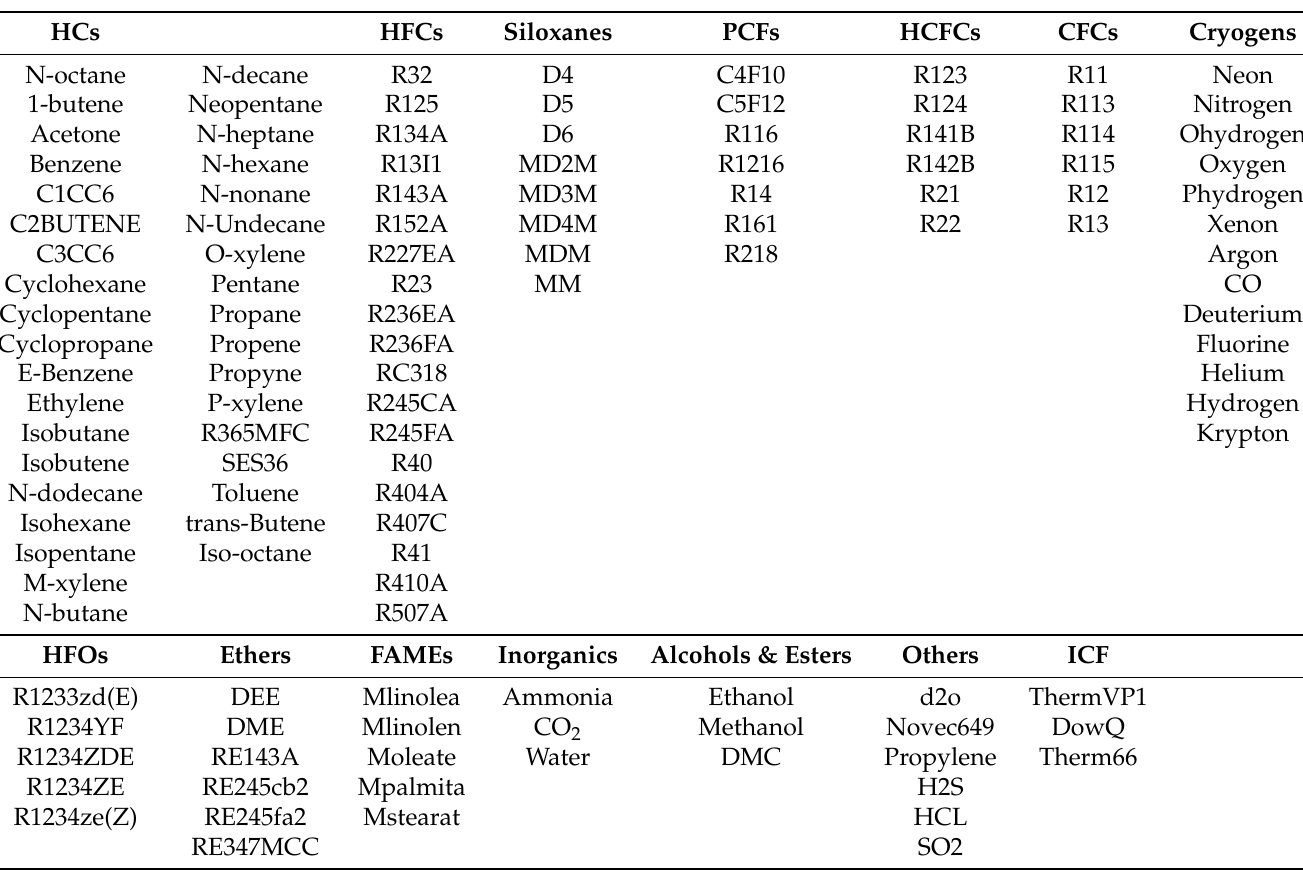
Table A1. HCs, HFCs, Siloxanes, PCFs, HCFCs, CFCs, and other candidates implemented in the